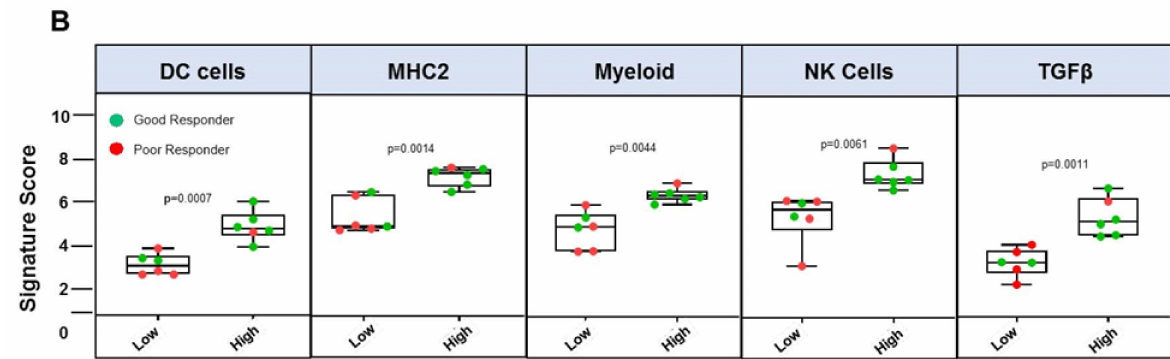
Figure 7. Box plots displaying the distribution of signature scores within the low- and high-expression groups (cutoff = score median) and correlation with ( A ) ELISPOT reactivity post-Vigil treatment. ELISPOT-positive (green), -negative (red) or not tested (black) patients are displayed. ( B ) Signature scores within the low- and high-expression groups (cutoff = score median) and correlation with overall survival > 12 months (GR) or <12 months (PR) post-Vigil treatment. GR (green), PR (red) patients are displayed. Whiskers represent minimum and maximum TIS scores. Statistical analyses of TIS scores were performed using unpaired T-tests with Welch